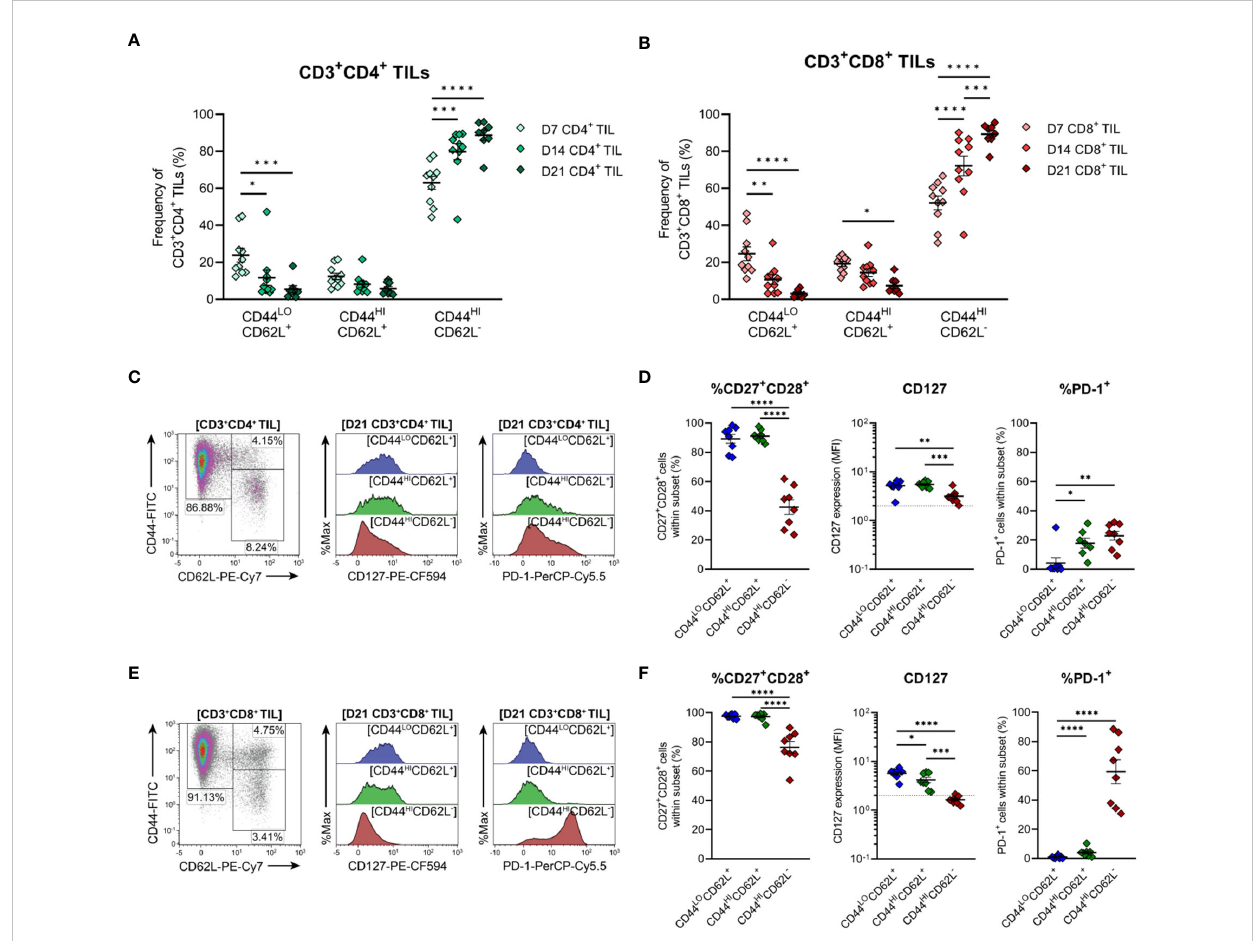
FIGURE 6 Distribution of CD4 + and CD8 + T cell subsets in fi ltrating MC38 tumours. (A, B) Frequencies of naïve (CD44 LO CD62L + ), central (CD44 HI CD62L + ), and effector (CD44 HI CD62L − ) memory T cells among CD3 + CD4 + (A) and CD3 + CD8 + (B) TILs during progressive MC38 tumour outgrowth (D7, D14 and D21). (C, E) Representative fl ow plots depicting the distribution of T cell subsets (based on CD44 and CD62L expression) and CD127 (IL-7R a ) and PD-1 expression in naïve (CD44 LO CD62L + ; blue), central memory/T CM (CD44 HI CD62L + ; green) and effector memory/T EM (CD44 HI CD62L − ; red) T cell subsets within CD3 + CD4 + (C) and CD3 + CD8 + (E) TIL isolated from D21 MC38 tumours. (D, F) Expression of both CD27 and CD28 (%CD27 + CD28 + ), CD127 (MFI) or PD-1 (%PD-1 + ) within CD44 and CD62L subsets of CD3 + CD4 + (D) and CD3 + CD8 + (F) TIL isolated from D21 MC38 tumours. In graphs depicting CD127 expression, dotted lines represent the threshold for CD127 positivity determined from fl uorescence-minus-one controls. All density plot percentages indicate frequencies as the proportion of the gated population (indicated in bold titles with square brackets). All data are representative of 8-10 biological replicates per timepoint. Graphs represent the mean and standard error of the mean (SEM, error bars). Statistical analyses were performed using two-way (A, B) or one-way (D, F) ANOVA with post-hoc Tukey test to correct for multiple comparisons. *p ≤ 0.05; **p ≤ 0.01; ***p ≤ 0.001; ****p ≤